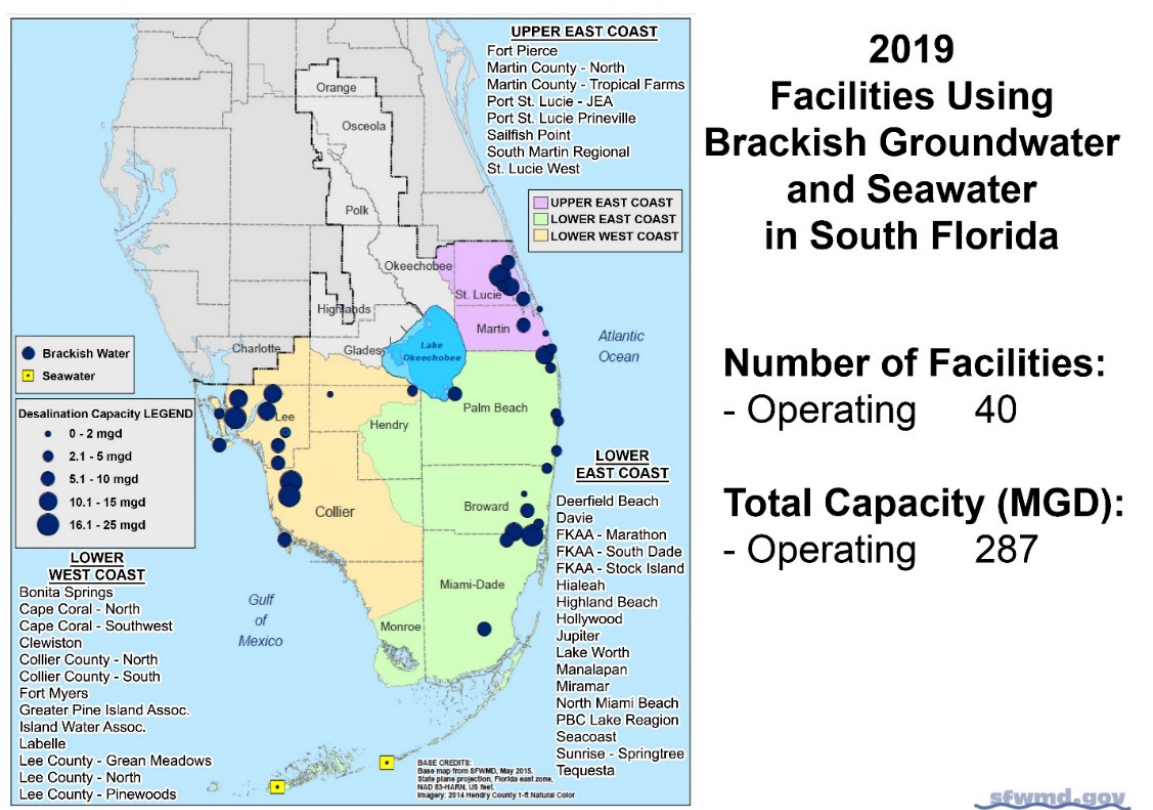
Figure 3. Locations and capacities of operating BWRO desalination plants in Southern Florida [21].